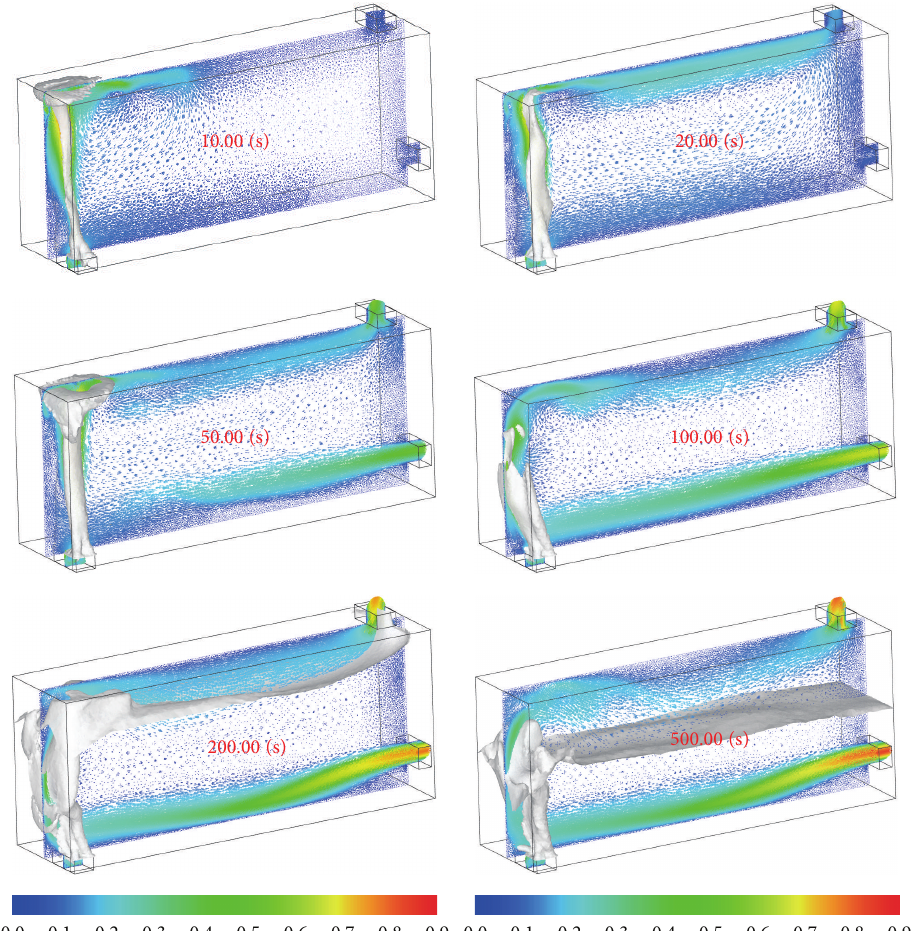
Figure 6: Vectors and 4% volumetric concentration